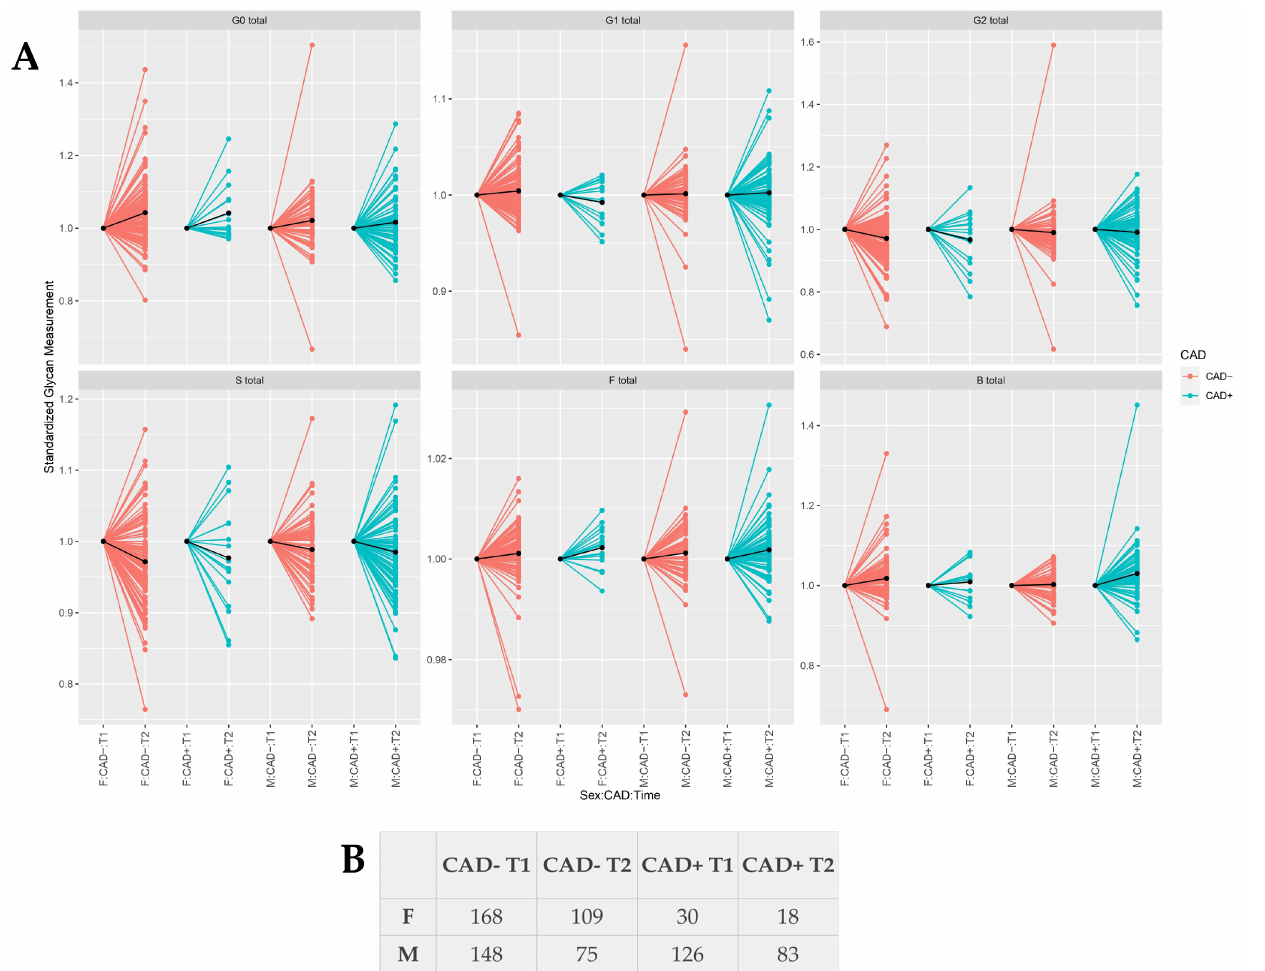
Figure 2. ( A ) Differences in sex-stratified IgG glycome composition during the follow-up period in CAD − and CAD+ cases. ( B ) Number of samples analyzed at each time point. G0—agalactosylation, CAD − and CAD+ cases. ( B ) Number of samples analyzed at each time point.